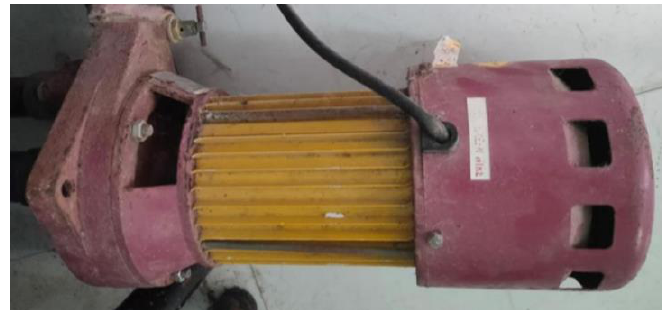
Figure 4. Motor used for research. Figure 5. Motor (fan-cooled) drawn using Motor-CAD software (according to specifications of the chosen motor).